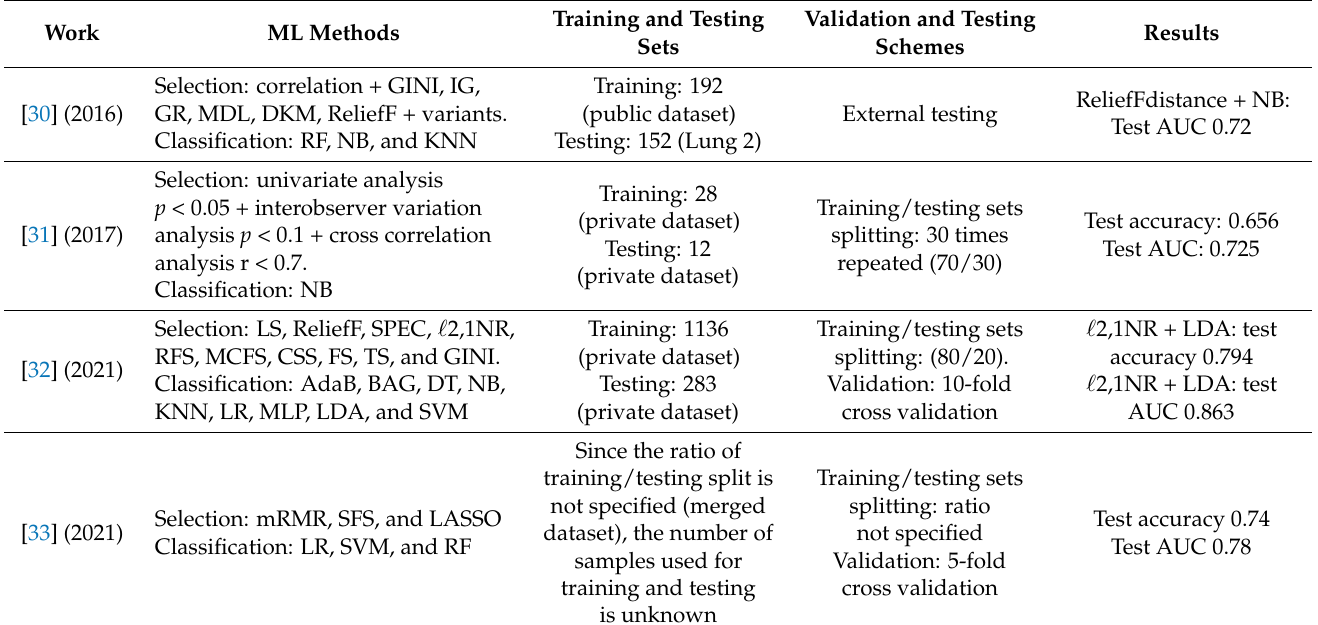
Table 6. A binary classification (SCC and ADC) comparison between the works, in which machine learning methods, validation and testing schemes, as well as the best averaged results are